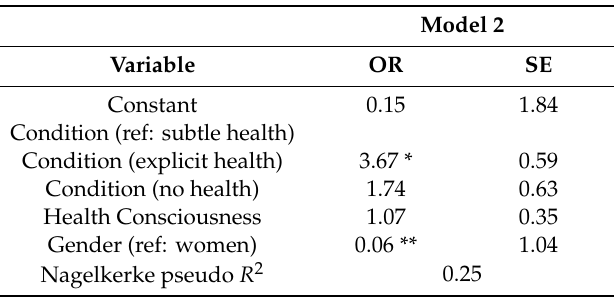
Table 4. Results of the logistic regression models for the logit to choose a healthy food product with the subtle health condition as referent ( n = 142